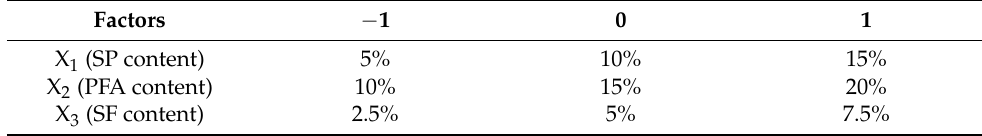
Figure 4. The test of compressive strength.